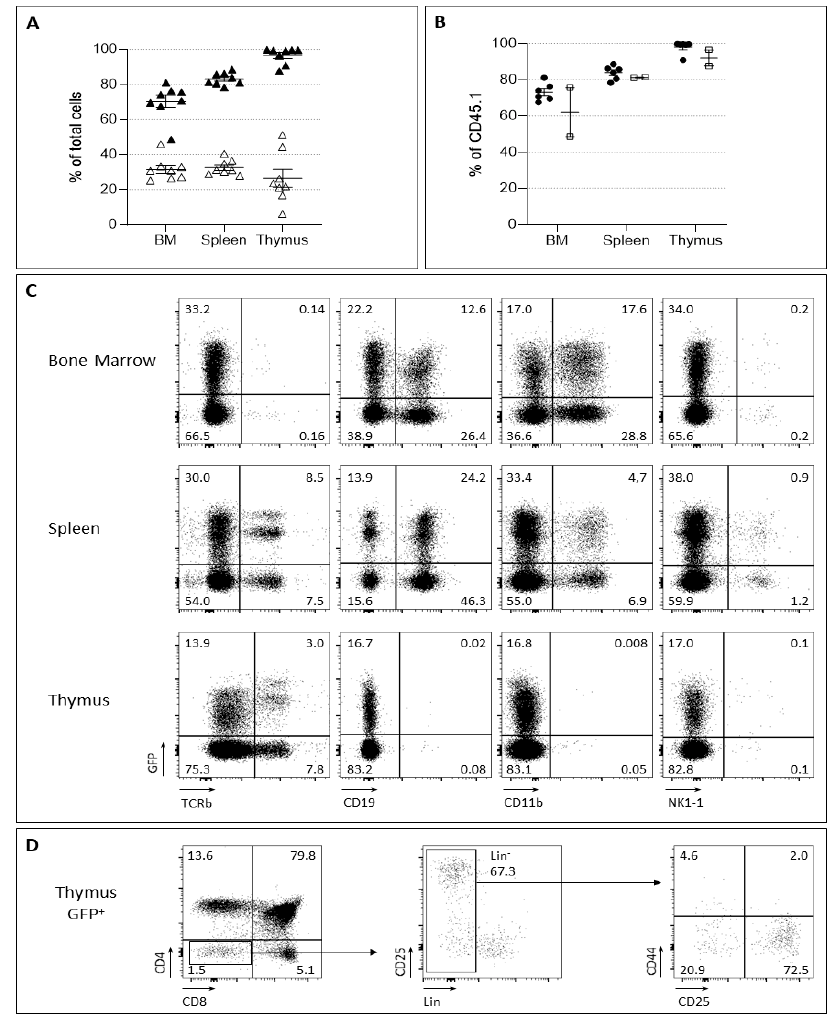
Figure 4. Analysis of the barcoded HSC reconstitution potential. ( A ) Percentages of donor type cells CD45.1 + in the bone marrow (BM), spleen and thymus (dark triangles). The percentages of CD45.1+GFP + cells is also indicated (empty triangles). Each dot represents one mouse. ( B ) Mice were studied 6 weeks post-graft (dark dots) or 14 weeks post-graft (empty square dots) with barcoded HSC. The percentage of CD45.1 + donor type cells detected in the BM, spleen and thymus is indicated for all mice analyzed. ( C ) An example of barcoded HSC grafted mice analyzed 6 weeks after transplantation. BM, thymus and spleen were studied for the presence of myeloid (CD11b + ), B (CD19 + ), NK (NK1.1 and T (TCR β )) populations. ( D ) Analysis of the thymus of the same mouse. Gating within the donor CD45.1 + GFP + is shown. Mature thymic subsets (CD4, CD8) as well as progenitors (Lin - CD44/CD25) are present.